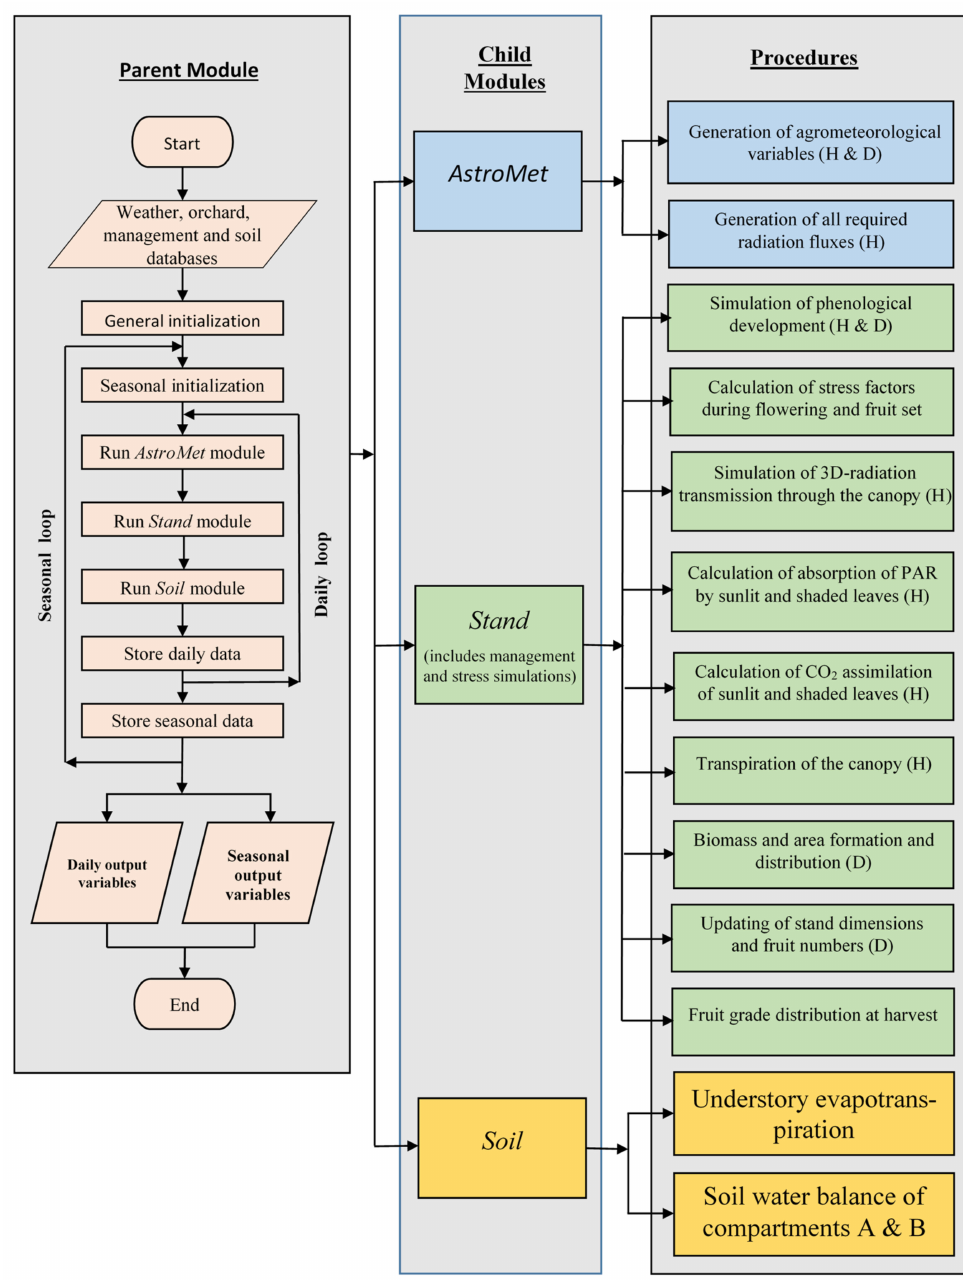
Figure 1. Relational diagram of the model CSS.Pome, showing the main modules and procedures and the communication between these structural